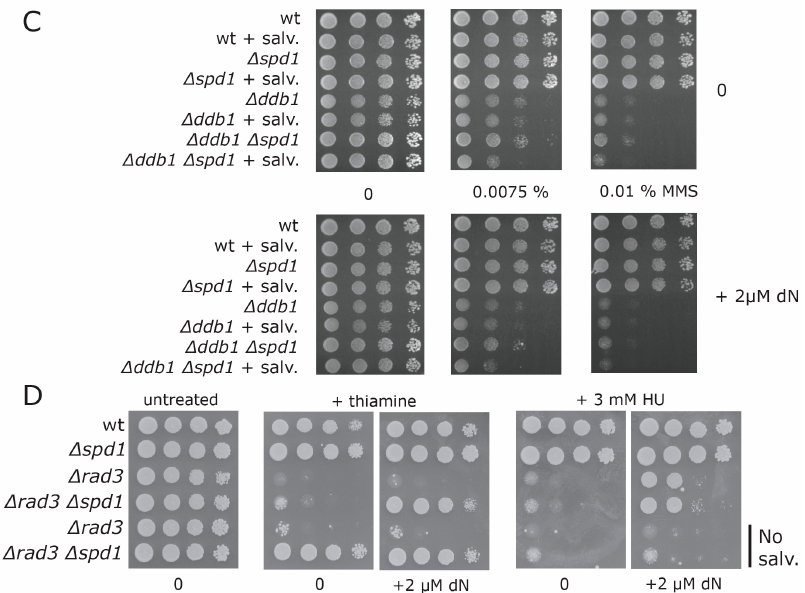
Figure 5. Salvage does not overcome S phase problems caused by Spd1 accumulation. ( A ) FACS profiles of G1 synchronized cdt2 TR cells expressing the salvage pathway. The cells were released in either the absence of presence of thiamine (to induce Spd1 accumulation). The culture in the right panel shows cells that were supplied with 2 µM of dN in addition to thiamine. ( B ). cdt2 TR or cdt2 TR Δ spd1 cells expressing the salvage pathway were treated with thiamine and/or 2 µM dN, as indicated. Cells were harvested after four hours, and Cds1 kinase activity against myelin basic protein (MBP) was monitored. Lower panel shows a Western blot of hemagglutinin-tagged Cds1 (HA-Cds1), with immunoglobulin G (IgG) heavy chain serving as a loading control. ( C ) Cells of the indicated genotypes were spotted on plates containing the indicated concentration of methyl methanesulfonate (MMS). “+ salv” means strains expressing the salvage pathway. Plates in the lower panel contain 2 µM of dN. ( D ) Strains of the indicated genotypes were spotted on plates with the indicated supplements (thiamine, 3 mM HU, or 2 µM dN) and grown at 30 °C for three days. All strains contain the cdt2 TR allele. Strains in the two last rows do not express the salvage pathway.